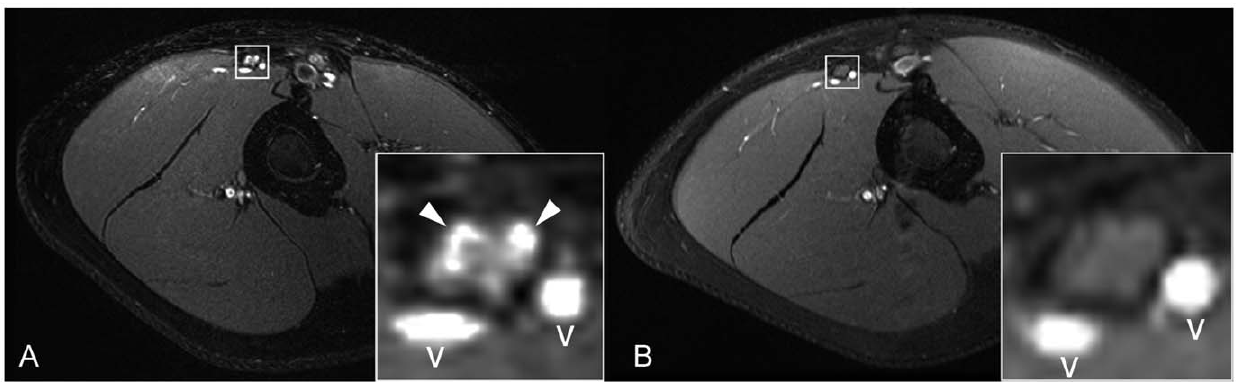
Figure 4. Differentiation of fascicular lesions versus small vessels. [A] T2-w image in combination with [B] contrast-enhanced T1-w image with fat-saturation at the same position allows discriminating fascicular lesions (arrowheads) from adjacent small vessels (v).